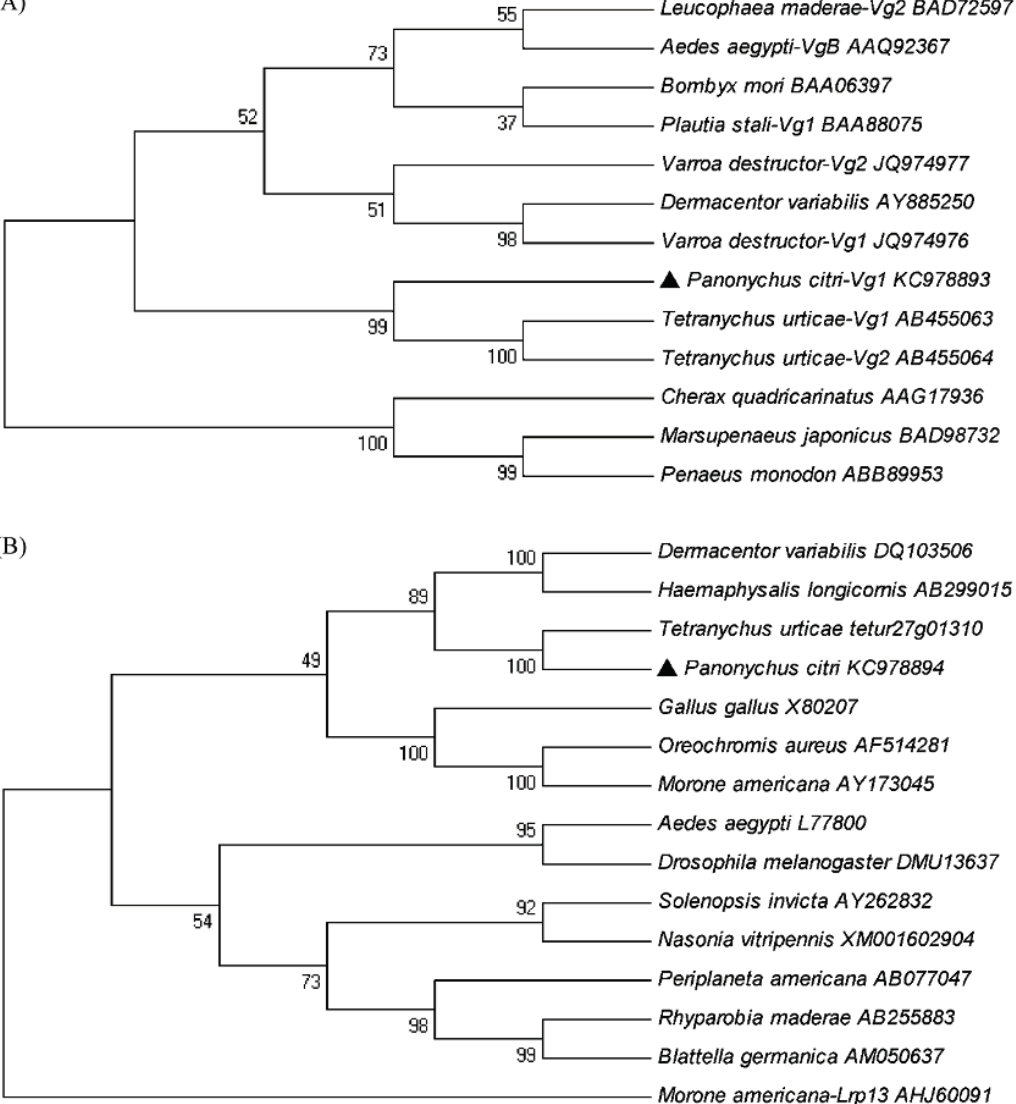
Figure 3. Phylogenetic relationship of vitellogenin 1 ( PcVg1 , ▲ ) ( A ) and vitellogenin receptor ( PcVgR , ▲ ) ( B ) of Panonychus citri with those of other arthropod species.